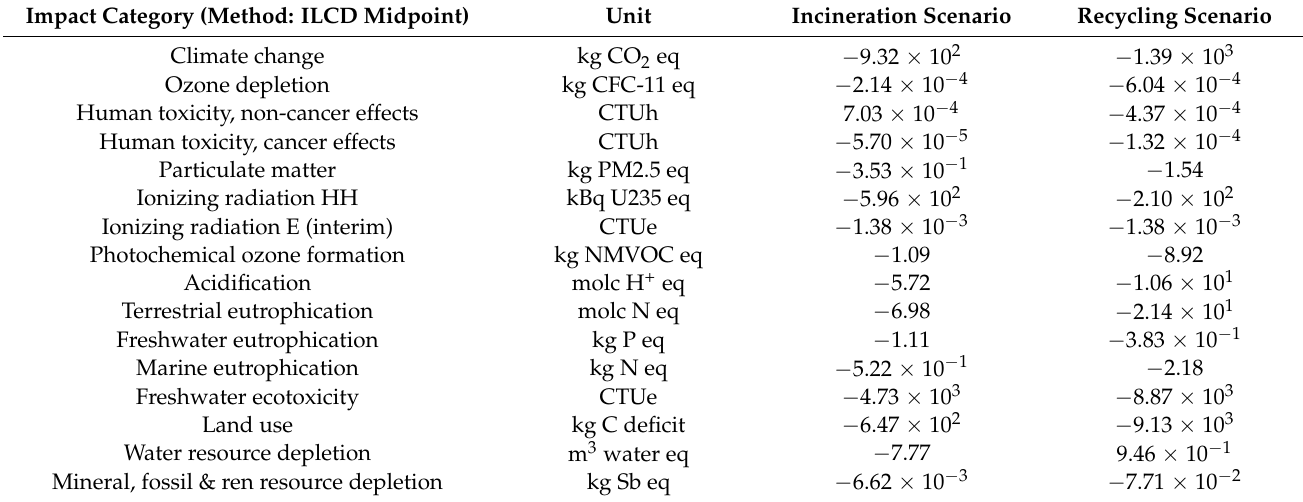
Table 2. Impact results for the two analysed EoL scenarios for 1 t of ELT.